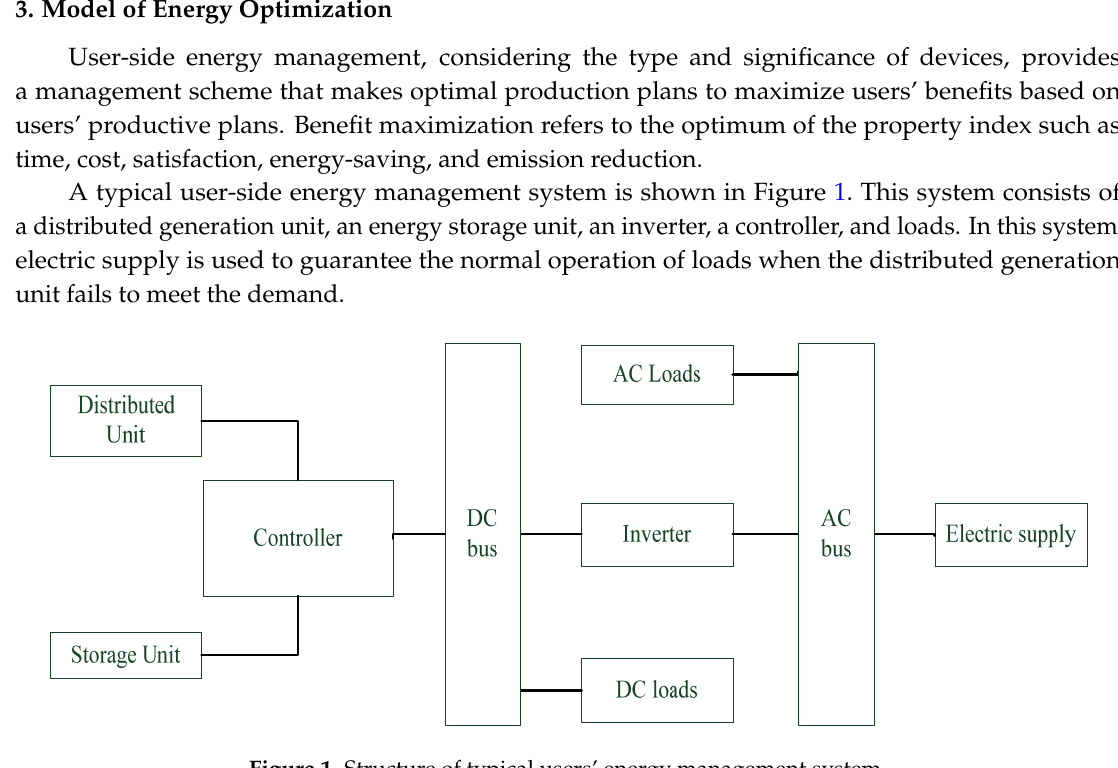
Figure 1. Structure of typical users’ energy management system.